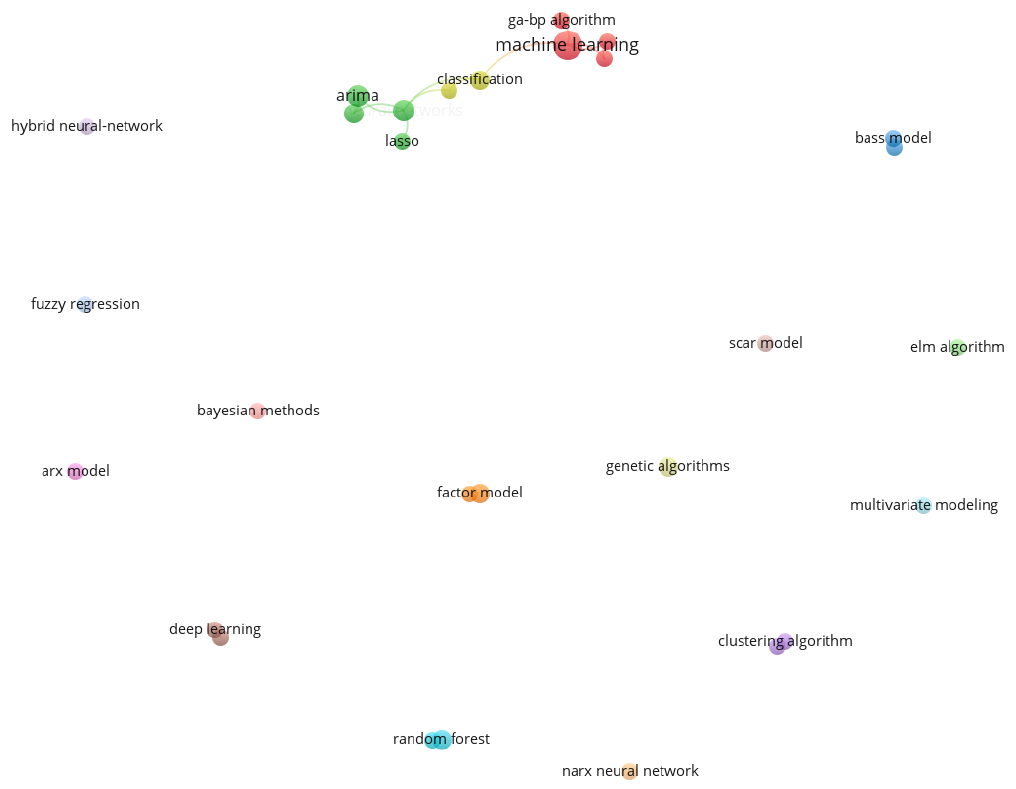
Figure 5. Bibliometric map of keywords co-occurrences (minimum 1) results from WoS based on modified Query 2. Source: Authors’ elaboration performed in the VOSviewer (version 1.6.18).